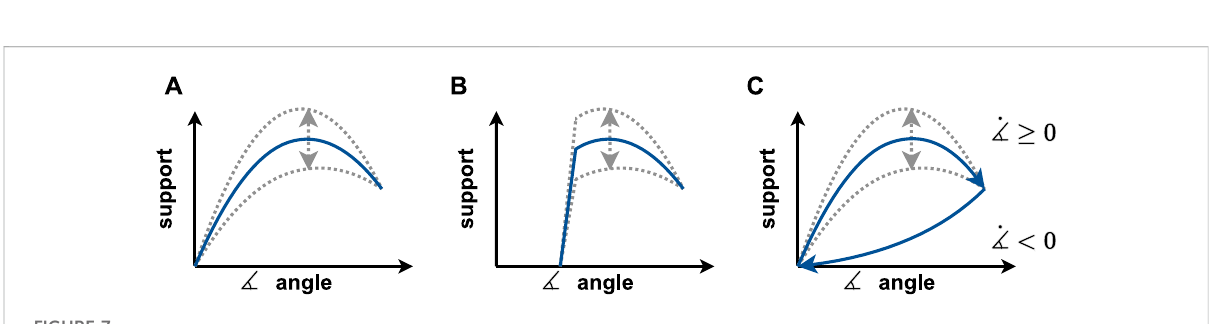
FIGURE 7 Three exemplary support curves for different scenarios: (A) angle-dependent but static force scalable in level; (B) static support for steady hold only at and above head level, scalable in height; (C) direction-dependent support curve for dynamic support, scalable in height.